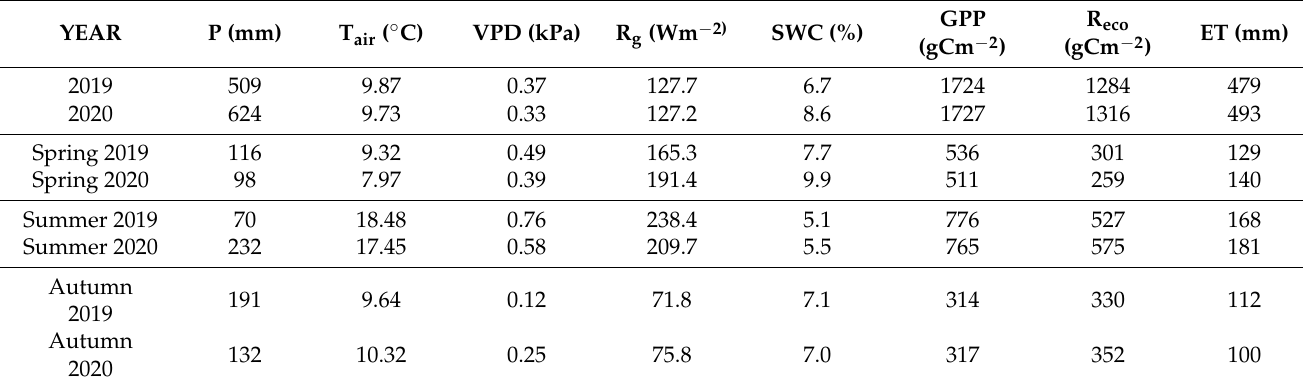
Table 2. Annual and seasonal (spring: March–May, summer: June–August, and autumn: September–November) precipita- tion totals (P), mean vapor pressure deficit (VPD), mean global radiation (R g ), mean soil water content (SWC), and totals of gross primary productivity (GPP), ecosystem respiration (R eco ) and evapotranspiration (ET) during the period 2019–2020 at the ME